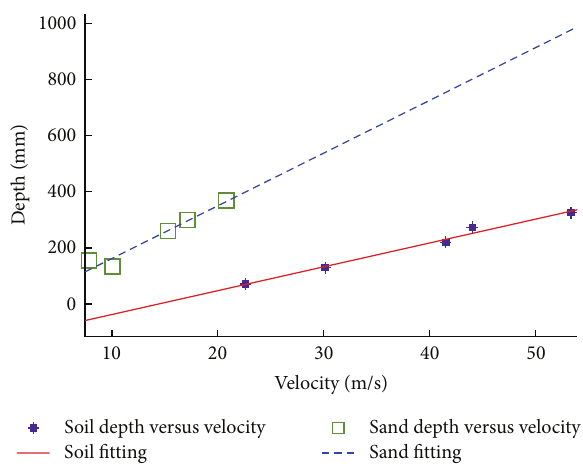
Figure 6: Penetrating depth versus velocity in soil and sand.